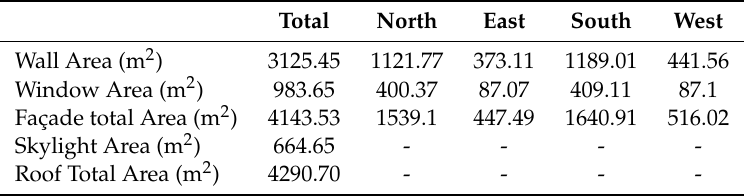
Table 1. Different dimensions of the envelope components.